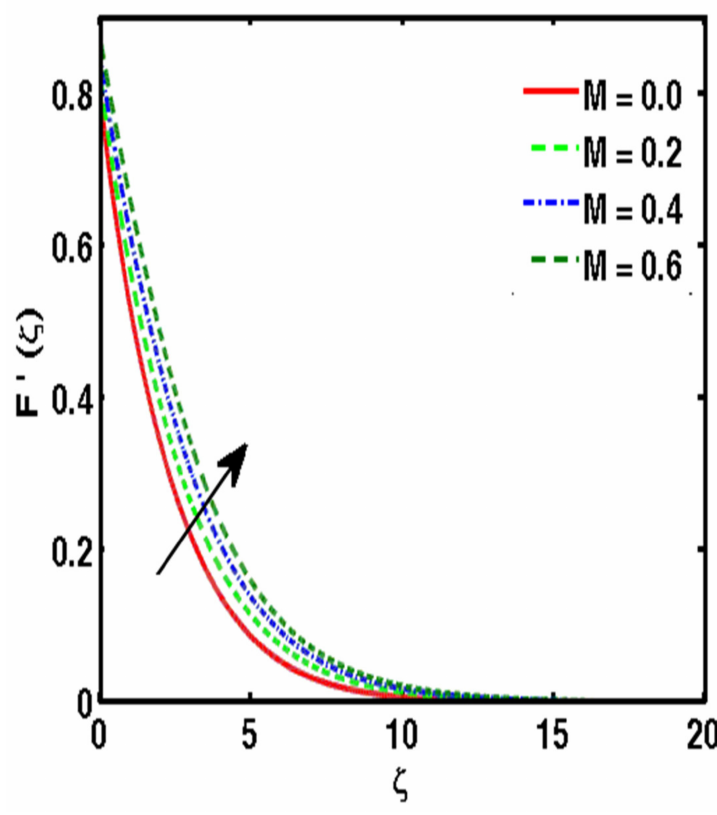
Figure 9. Variation of M and F (cid:48) ( ζ ) .